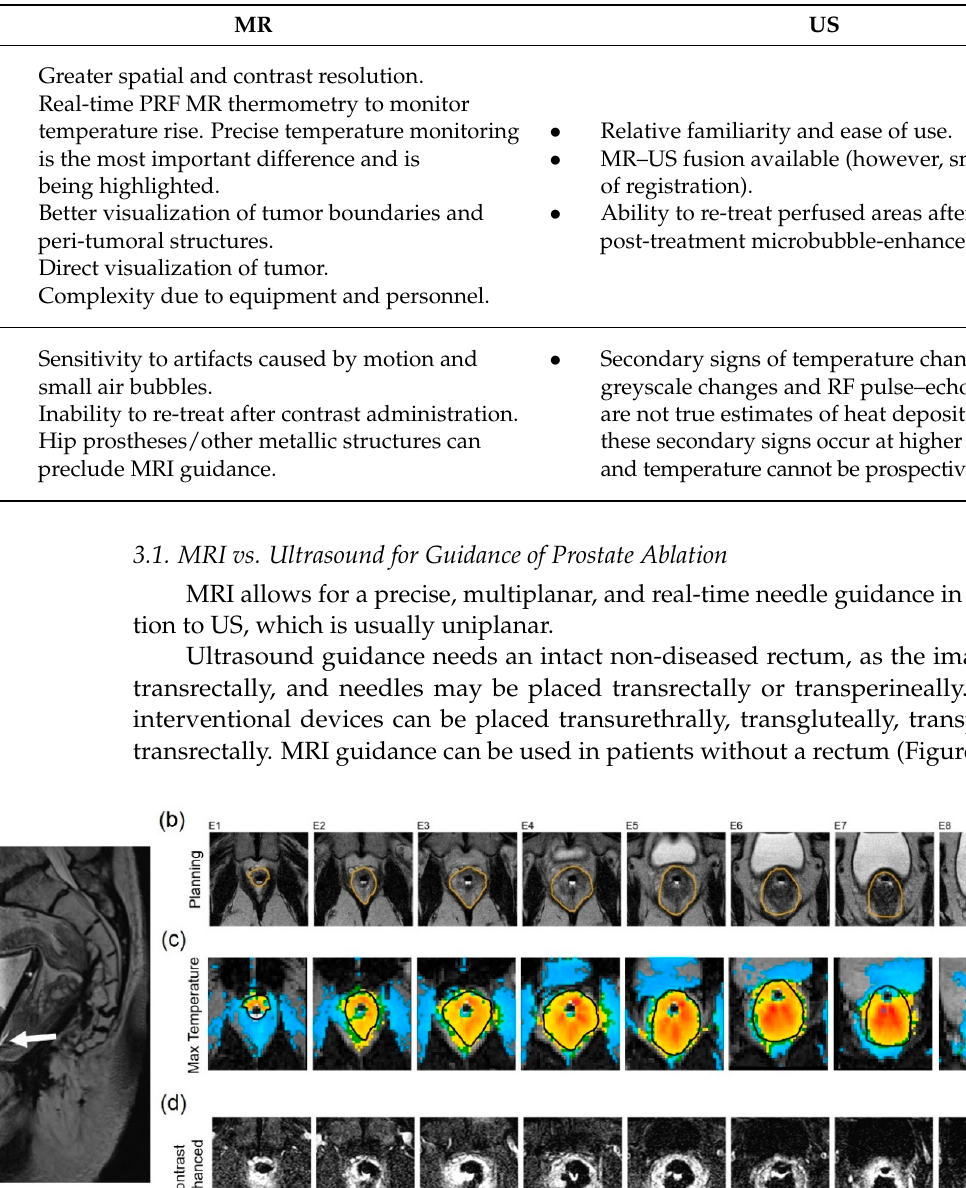
Table 2. Comparison of MR- vs. US-imaging guidance for prostate ablation.